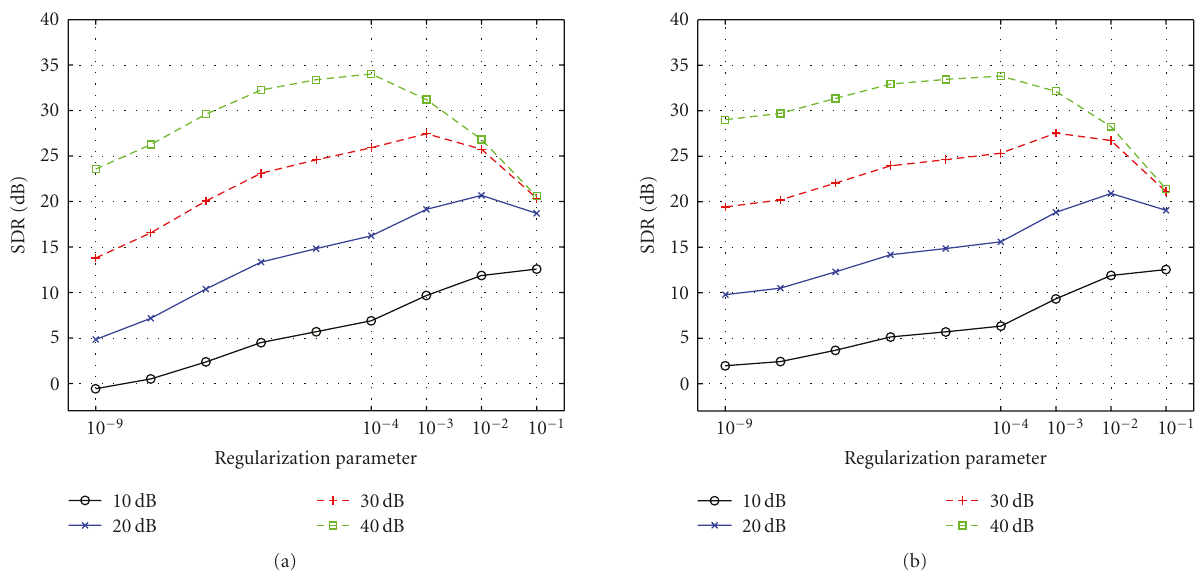
Figure 9: Performance as a function of regularization parameter for SNR values of 10, 20, 30, and 40 dB ( d = 500). Filter length was set at M = 1333 (a), and M = 1333 + 500 (b), respectively.